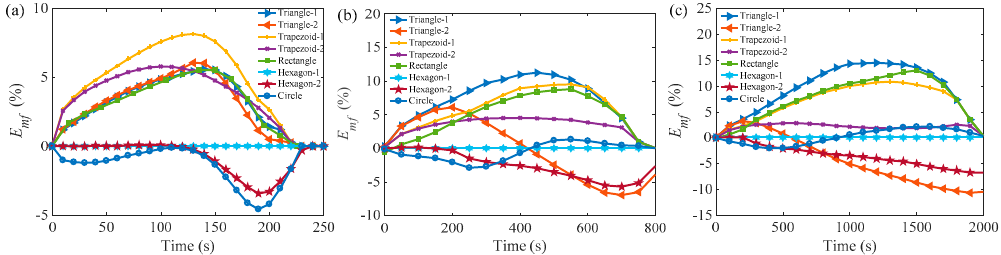
Figure 11. Instantaneous enhancement ratios of the liquid fraction in the triangular, trapezoidal, square, hexagonal, and circular cells ( AR = 0.5) ( a ) Ra = 3.095 × 10 5 ; ( b ) Ra = 4.83 × 10 6 ; ( c ) Ra = 3.87 × 10 7 .